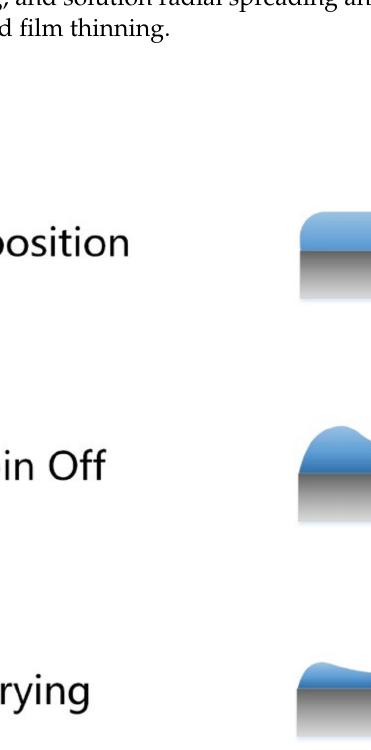
Figure 2. Schematic diagram of